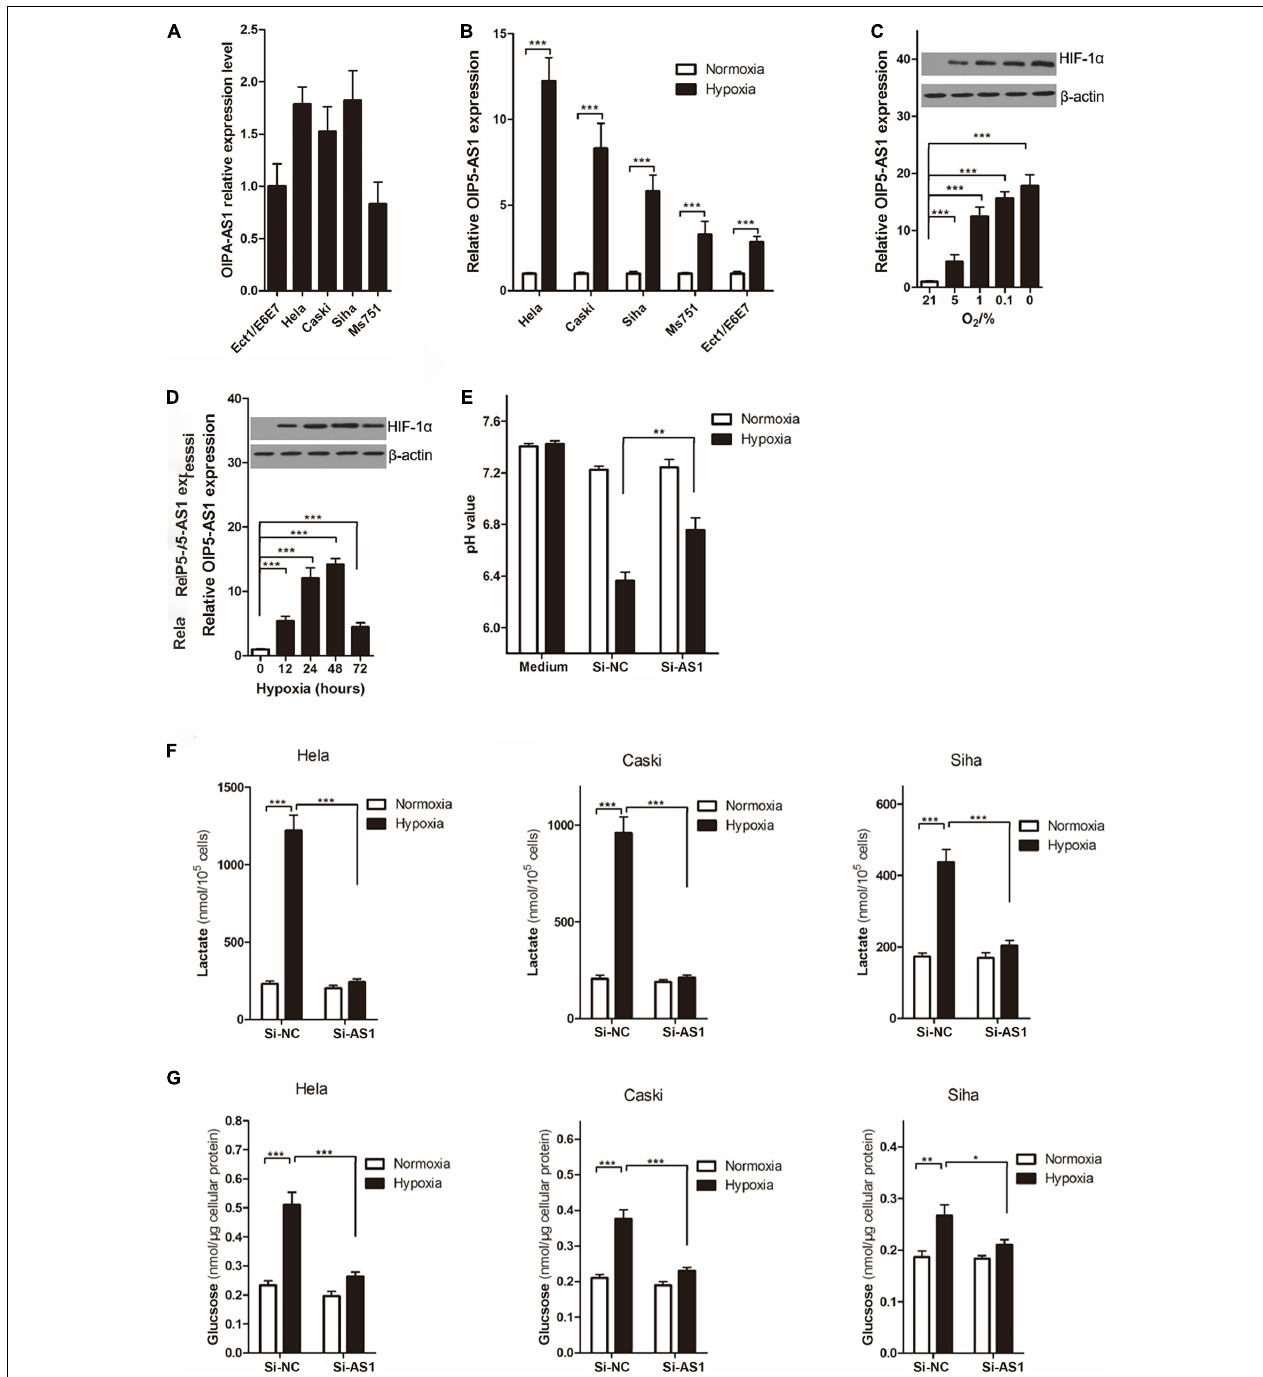
FIGURE 3 | OIP5-AS1 mediates the promoting effect of hypoxia on Warburg effect in cervical cancer cell. (A) RT-qPCR analysis was used to quantify the copy numbers of OIP5-AS1 transcript per cell in the indicated tumor cells and non-transformed cells. Data were shown as mean ± SD of three individual experiments. (B) We cultured Hela, Caski, and Siha cells under 20% O 2 (normoxic) or 1% O 2 (hypoxic) for 24 h, and RT-qPCR analysis of the indicated OIP5-AS1 levels. Data are shown as (mean ± SD), *** was P < 0.001 and P value was calculated by Student’s t test. (C,D) RT-qPCR analysis of the indicated OIP5-AS1 levels in Hela cells under different oxygen concentrations (C) or under hypoxia for 24 h (D) . Western blot analysis shows HIF-1 α protein in Hela cervical cancer cell. Data are shown as (mean ± SD), *** was P < 0.001 and P value was calculated by post hoc comparisons. (E) The pH value of Hela cells knocking down OIP5-AS1 or its control were detected. Data are shown as (mean ± SD), ** was P < 0.01 and P value was calculated by Student’s t test. (F,G) Levels of lactate (F) in the culture medium and intracellular glucose (G) in the culture medium of Hela, Caski, and Siha cells after culturing for 24 h under hypoxia. Data were shown as mean ± SD of three individual experiments. * was P < 0.05, ** was P < 0.01 and *** was P < 0.001, and P value was calculated by Student’s t test.